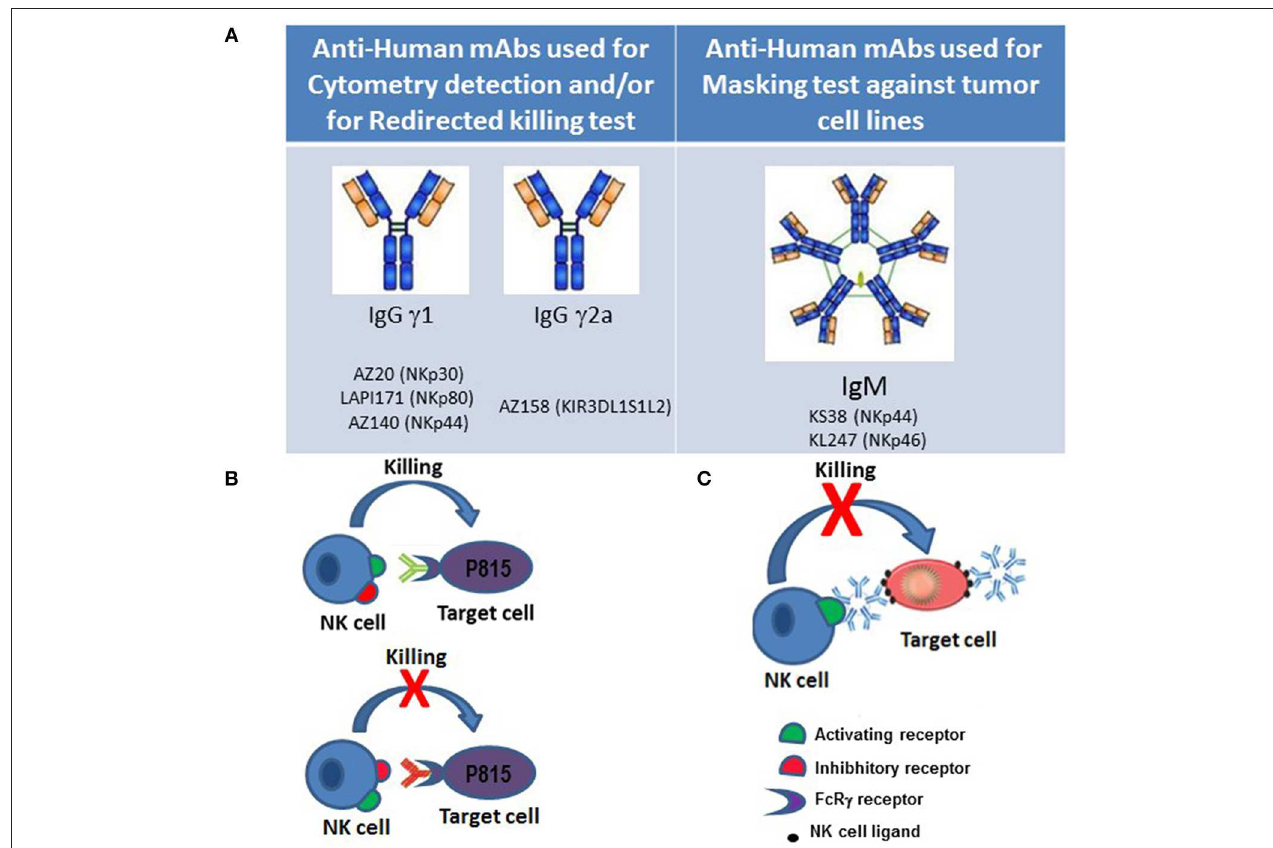
FIGURE 1 | Approaches to functional studies of NK cell receptors. (A) Isotypes of monoclonal antibodies against NK cell surface molecules that were generated in our laboratory and used for flow cytometry and/or cytotoxic assays against tumor cell lines. (B) In redirected-killing assays, the murine mastocytoma Fc γ R + P815 cell line is used as target. Binding of murine mAbs of γ 1, γ 2a, and γ 2b IgG isotypes to NK receptors on one hand, and to the Fc γ R on P815 cells on the other, allows cross-linking of activating and inhibitory NK cell receptors, thereby permitting to study their role in NK cell-mediated cytotoxicity. (C) Anti-NK cell activating receptors of IgM isotype can mask receptor-ligand interactions blocking cytolysis of target